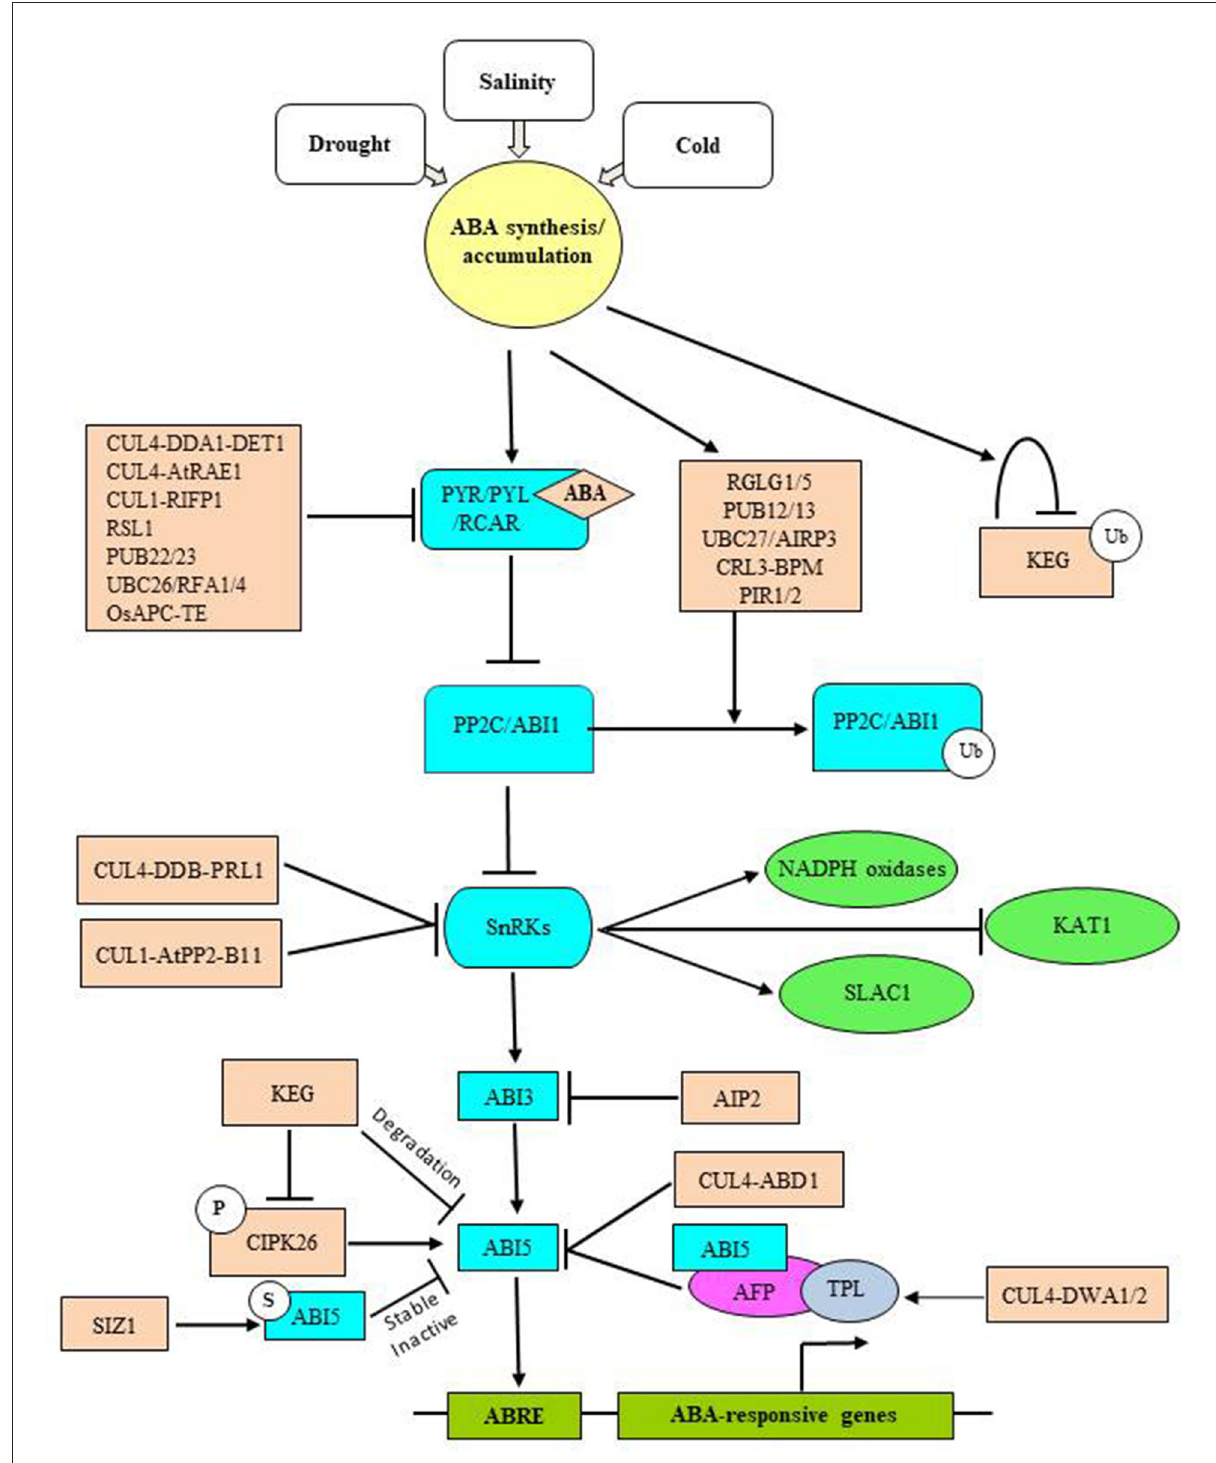
FIGURE5 UPS-mediated ABA-dependent stress signaling/tolerance in plants. Abiotic stress triggers ABA biosynthesis and accumulation. In the absence of stress conditions, the positive regulators of ABA signaling like ABA receptors and TFs are maintained in a repressed state to inhibit ABA signaling and thus the expression of ABA-responsive genes. This is largely achieved through numerous E3 ligases that differentially modulate the turnover of ABA receptors and SnRKs, as these are major effectors of ABA responses. SIZ1-mediated SUMOylation opposes KEG-mediated degradation of ABI5 to maintain moderate ABI5 levels under no stress conditions. Auto-ubiquitination and degradation of KEG under-enhanced ABA levels stabilize ABI5. Upon ABA accumulation, ABA binds its receptors, which together capture PP2C in a ternary complex to release PP2C